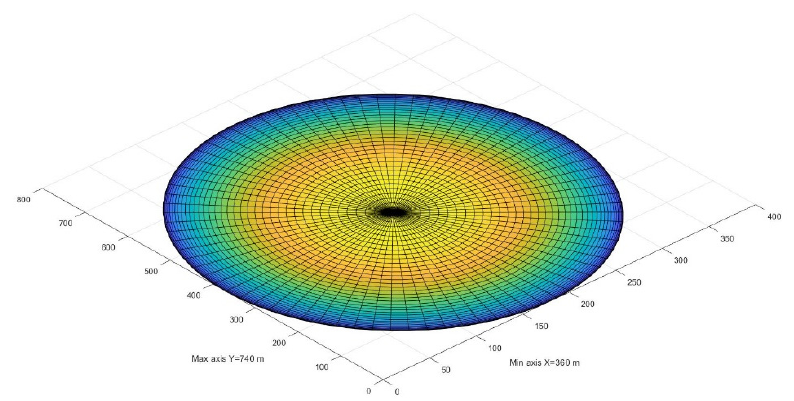
Figure 12. Two-dimensional plane view of the landslide geometric shape.